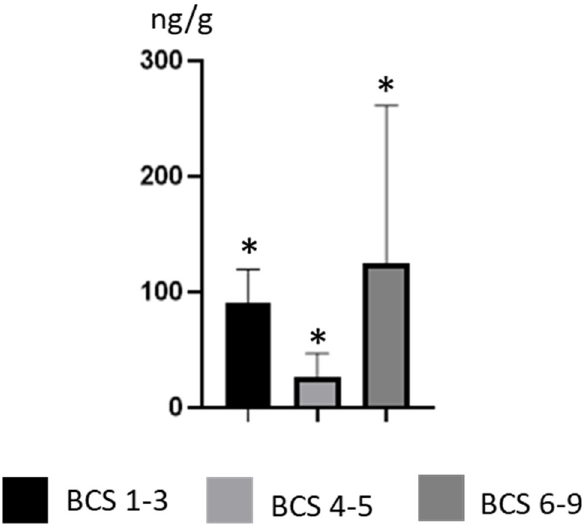
Figure 3. Mean concentration levels ( ± SD) of BPA in thinner dogs (BCS 1–3), dogs with normal weight (BCS 4–5) and dogs with obesity (BCS 6–9). Statistical differences ( p ≤ 0.05) are marked with *.